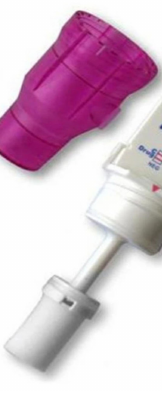
Figure 7. iScreen Test Device